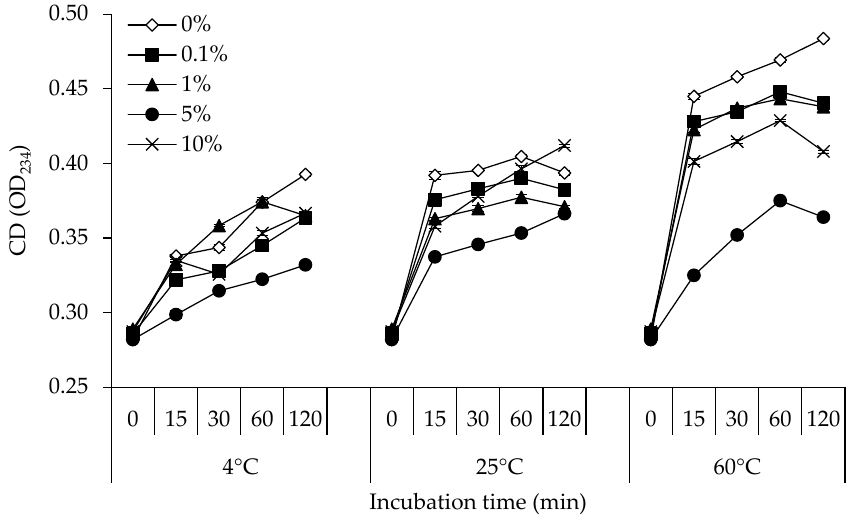
Figure 1. Changes in conjugated diene (CD) of lecithin liposome model system added with 0, 0.1, 1, 5, and 10% ( v / v ) of stingray non-protein nitrogen (NPN) incubated at 4, 25 and 60 °C for 0, 15, 30, 60, and 120 min. Bars indicate the standard deviation from triplicate determinations.